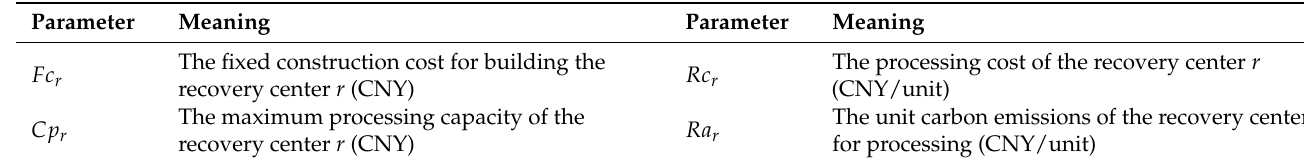
Table 6. Relevant parameters of the recycling center.